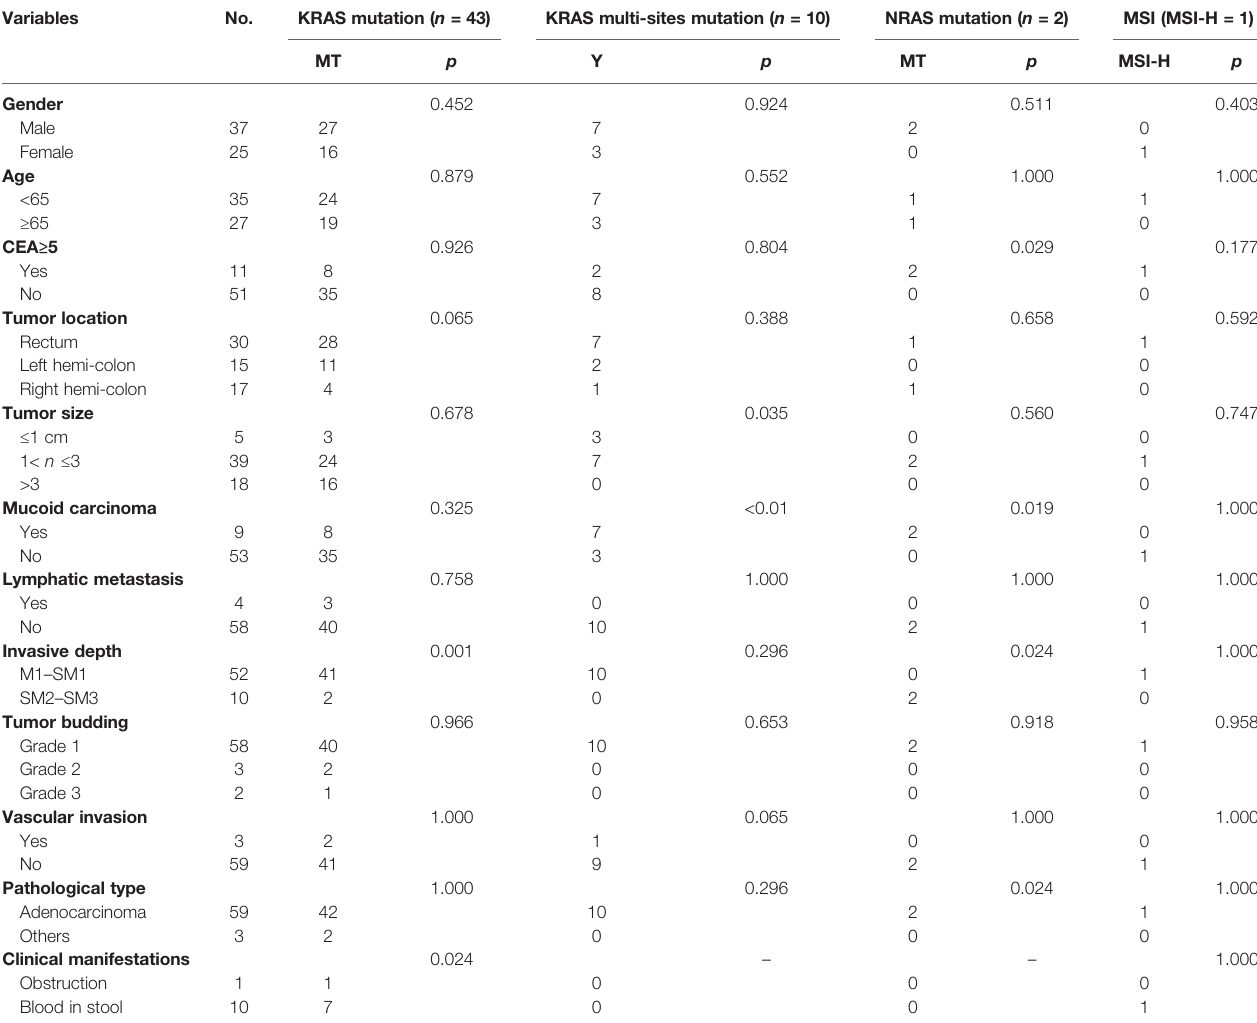
TABLE 2 | Clinicopathological association of KRAS, NRAS, and BRAF mutation and MSI in ECRC. Variables No. KRAS mutation ( n = 43) KRAS multi-sites mutation ( n = 10)